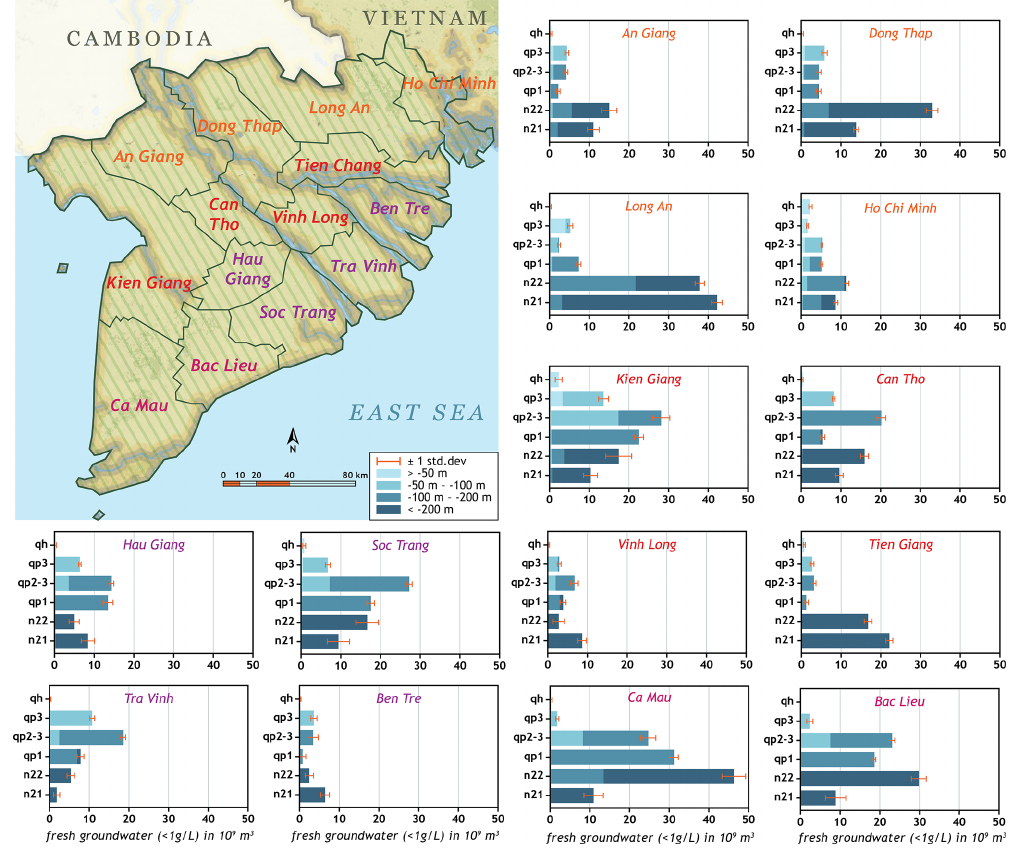
Figure 15. Volume of fresh groundwater in the aquifers for each province and depth interval (relative to m.s.l.), including uncertainty. Map copyright: © National Geographic, Esri, Garmin, HERE, UNEP-WCMC, USGS, NASA, ESA, METI, NCRAN, GEBCO, NOAA, increment P